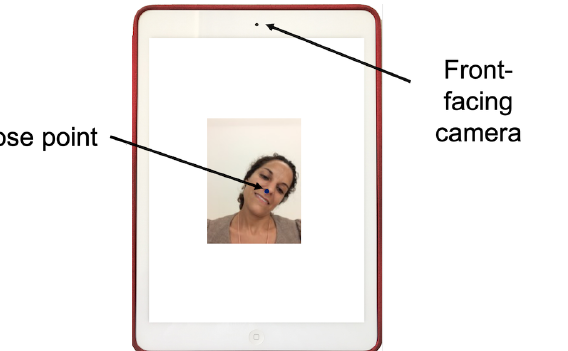
Figure 2. Screenshot of the experiment software with annotations on an Apple iPad Air (device in portrait orientation).